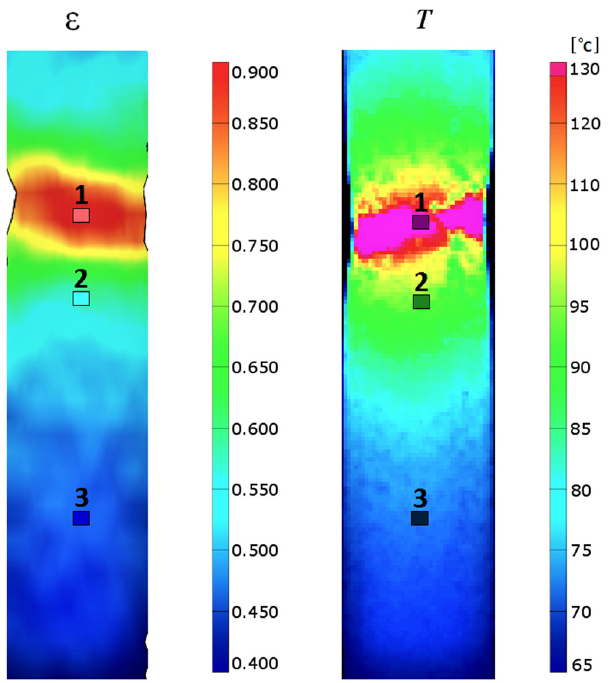
Figure 6. Strain and temperature fields just before the specimen fracture.